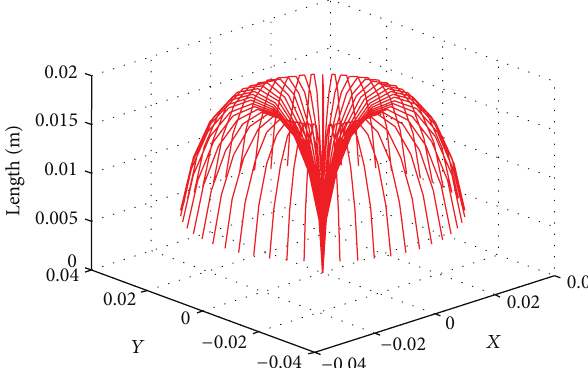
Figure 12: Approximate manipulator